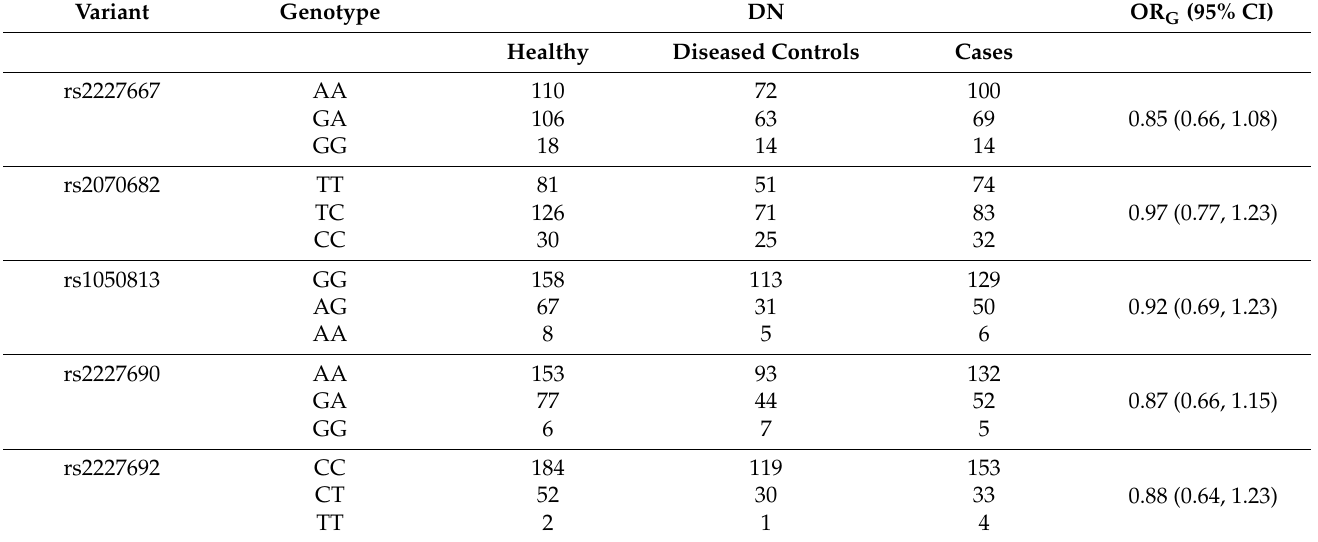
Table 2. Genotype frequencies of the participants and results of the association study.